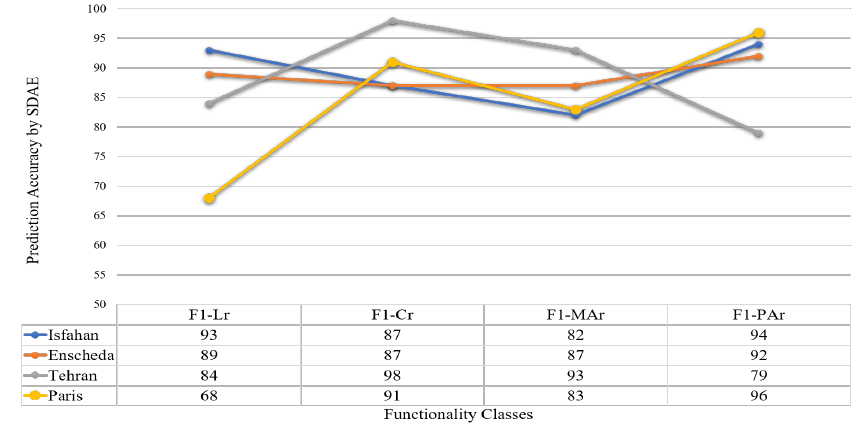
Figure 5. SDAE F1-score of functionality of each